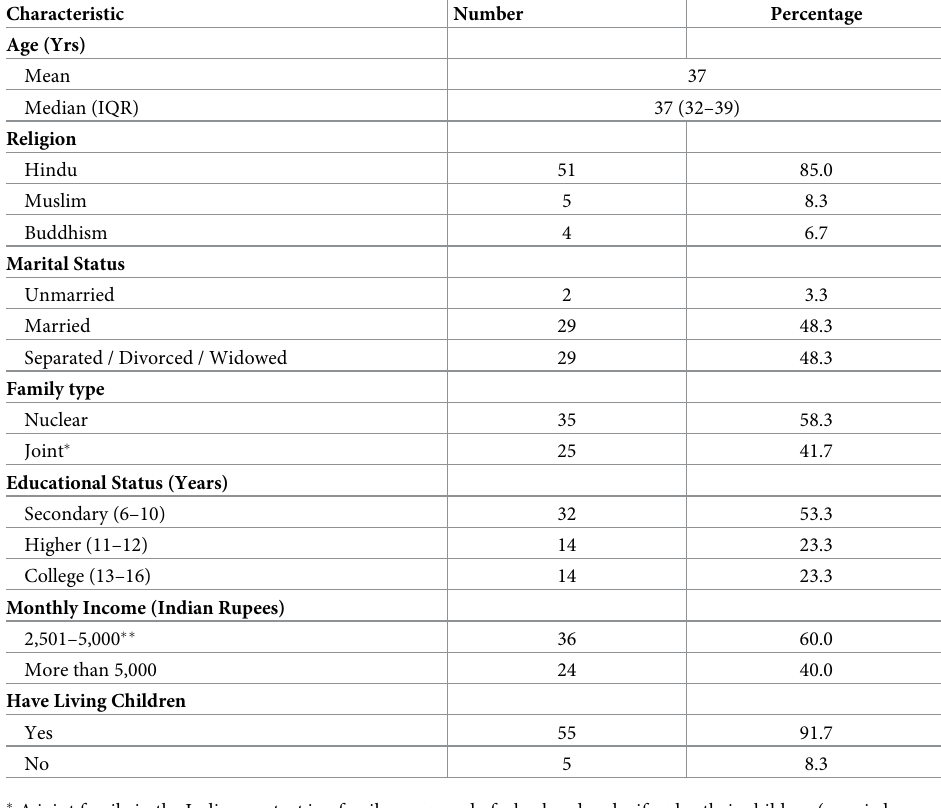
Table 2. Sociodemographic characteristics of the 60 outreach workers who participated in the discussion groups.